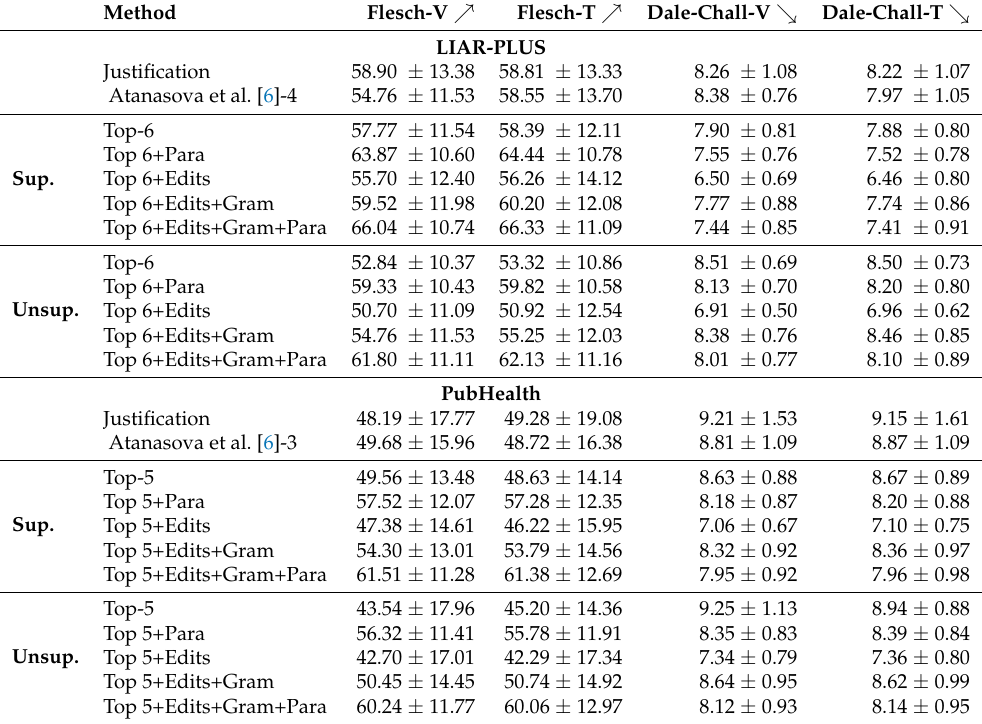
results of the two parts included in the Edits step—the iterative editing and the grammar correction. We find that the grammar correction improves the ROUGE scores with up to 8 ROUGE-L score points and up to 8 Flesch Reading Ease points. Table A2. Flesch Reading Ease (Flesch) and Dale–Chall Readability Score (Dale–Chall) for Validation (V) and Test (T) sets. Ablations are provided for the method as well – input selected sentences of Top-6, iterative-editing (Edits-IE), grammatical corrections (Edits-Gram), paraphrasing (Para).